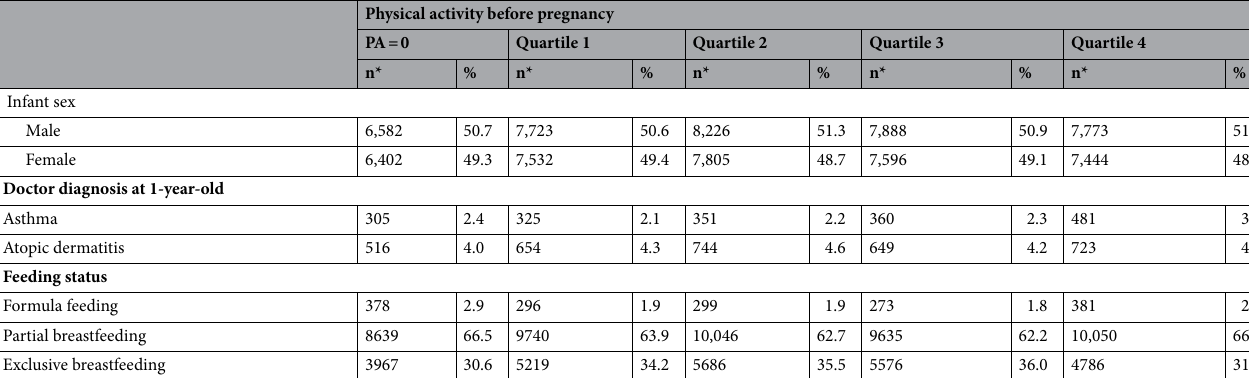
Table 1. Baseline characteristics of the study population categorized by physical activity before pregnancy. *Numbers in subgroups do not equal overall number because of missing data. PA physical activity, MET metabolic equivalent of a task, IQR interquartile range, K6 scale the Kessler six-item psychological distress scale, SD standard